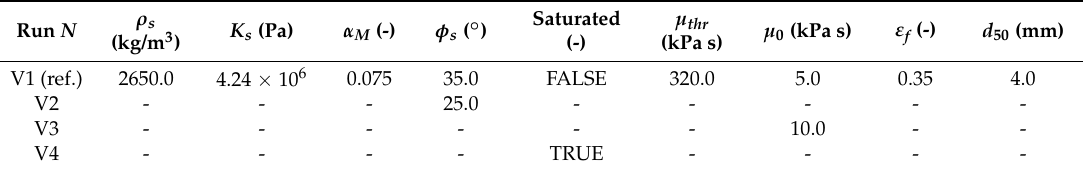
Table 3. Summary of the relevant model parameters for sensitivity analysis (symbol - denotes parameter invariance with respect to reference Run V1).